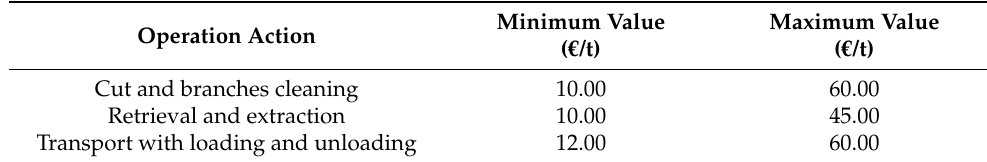
Table 6. Forestry works reference costs map (adapted from www.icnf.pt, accessed on 8 November